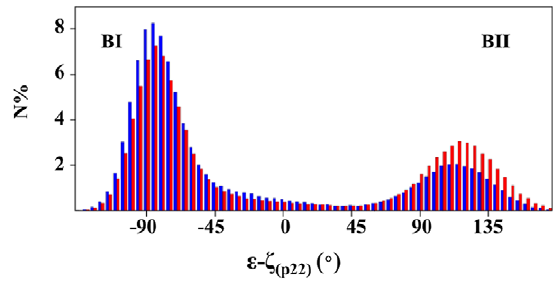
Figure 5. ( e - f ) distribution without and with Mg 2 + in the DNA major groove. N is the percentage of snapshots within each ( e - f ) p22 interval. The distribution of ( e - f ) p22 values was calculated on two groups of structures extracted from S0–S3. The first group (blue) corresponds to snapshots in which Mg 2 + does not interact with the DNA major groove. In the second group (red), Mg 2 + binds to the N7 and O6 atoms of A 22 /G 23 through three water-mediated hydrogen bonds. The BII population of the 5 9 phosphate group, p 22 ,